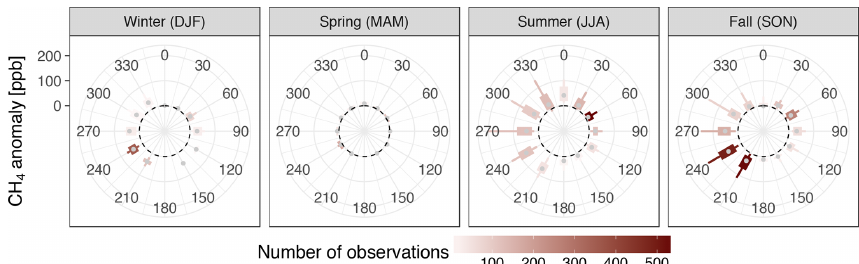
Figure 11. Same as Fig. 10, but for CH 4